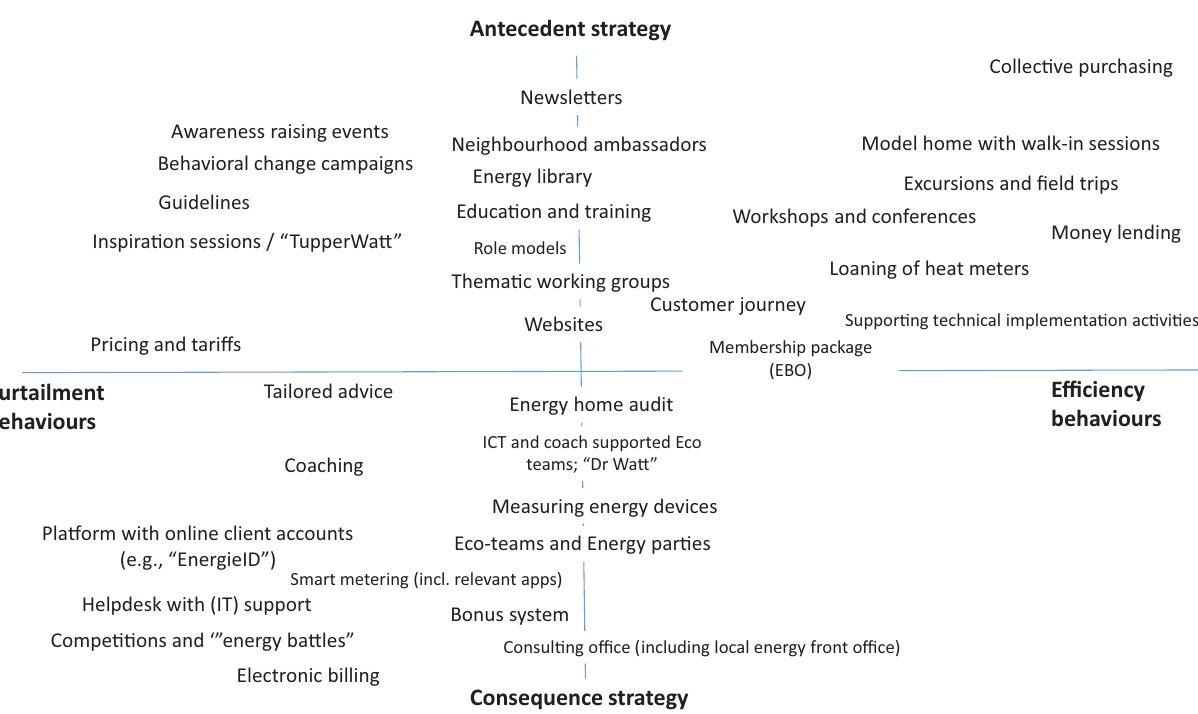
Figure 2. Classification of actions and measures implemented by REScoops to stimulate home energy savings. Source: Adapted from Hoppe and Coenen